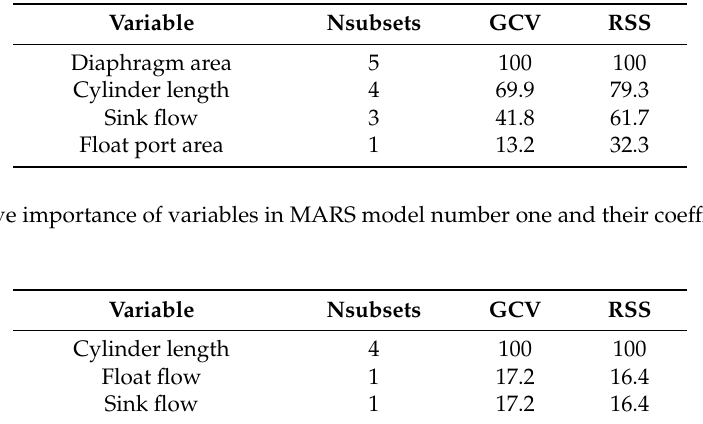
Table 5. Relative importance of variables in MARS model number one and their coefficients for feed with media.